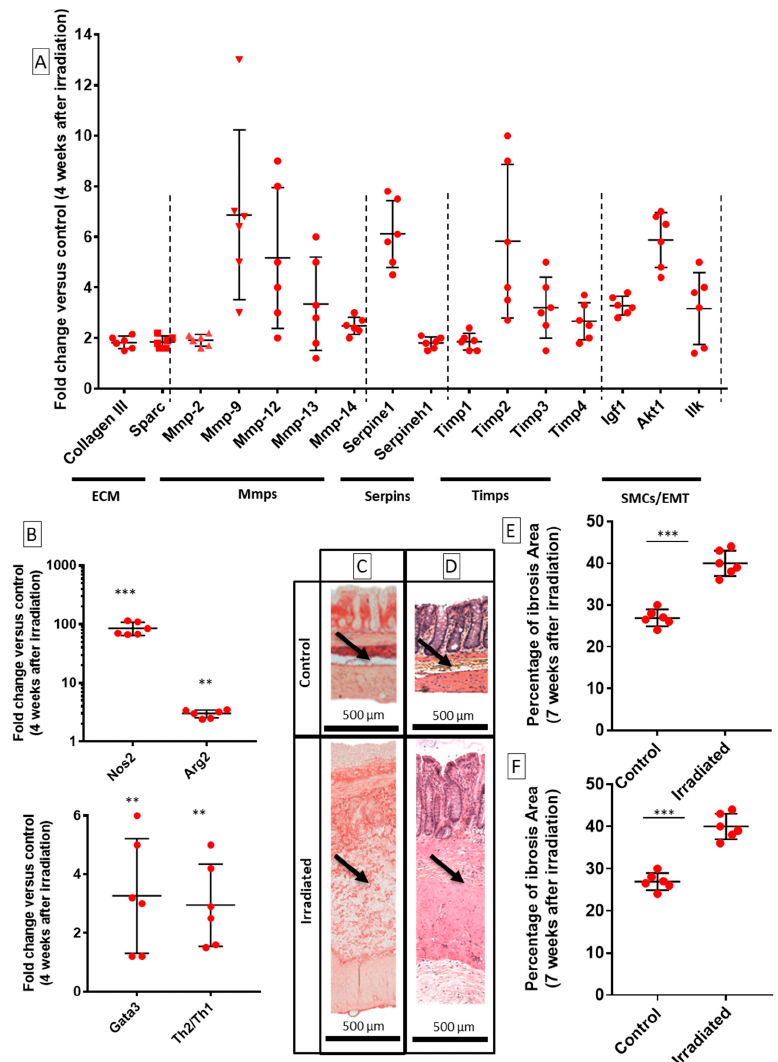
Figure 1. Features of radiation-induced colorectal fibrosis model in Sprague–Dawley rats. ( A ) mRNA fold changes of genes 4 weeks after irradiation that are normalized to Ywhaz and standardized against control (neither irradiated nor injected with mesenchymal stem cells (MSCs)). Extra cellular matrix (ECM) components, matrix metalloproteinases (MMPs), serpine-1 (PAI-1) and TIMPs were upregulated in colon–rectum area of irradiated rats. ( B ) mRNA fold changes of macrophage and T-cell response. ( C ) Representative histological images of colon of control and irradiated rats showing ECM (red) stained with Picrosirius Red (origin magnification: 40×). Seven weeks after irradiation, animals display oedema in submucosa that was caused by accumulation of ECM. ( D ) Representative images of colon of control and irradiated rats stained with HES 7 weeks after irradiation (original magnification: 40 × ). Black arrows indicate ECM accumulation compared to control. ( E ) Fibrosis deposition in the colon–rectum area of control and irradiated animals 7 weeks after irradiation. Percentage of fibrosis area quantified on Picrosirius Red-stained slides showing a significant increase in ECM deposition after irradiation. ( F ) Irradiation induces a significant thickening of tissue, particularly in submucosa and muscularis propria, 7 weeks after irradiation. Each group of animals was composed of 6 rats. Results were compared as follows: Irradiated group was compared to Control group. Two-group comparisons were performed with t -tests, while one-way ANOVAs, followed by Bonferroni t -tests, were used for multiple group comparisons. The results are expressed as mean ± standard deviation (SD). **: p < 0.01; ***: p ≤